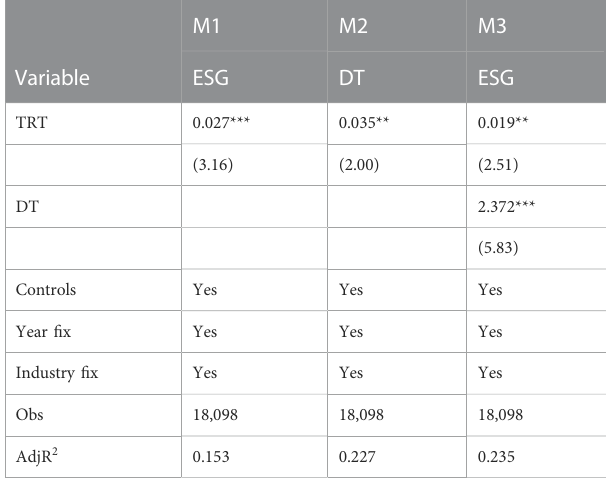
TABLE 7 Results of the replacing